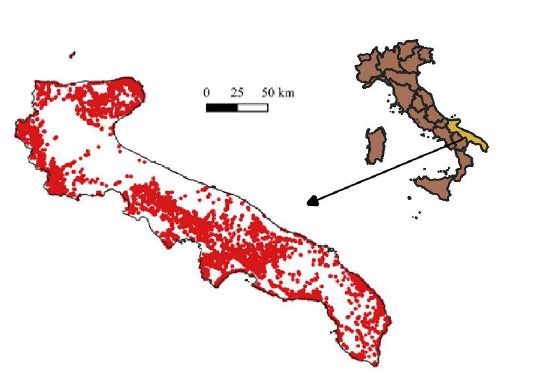
Figure 1 . Location of Apulia Region. In red, historical fire recorded in 2000-2018 period.